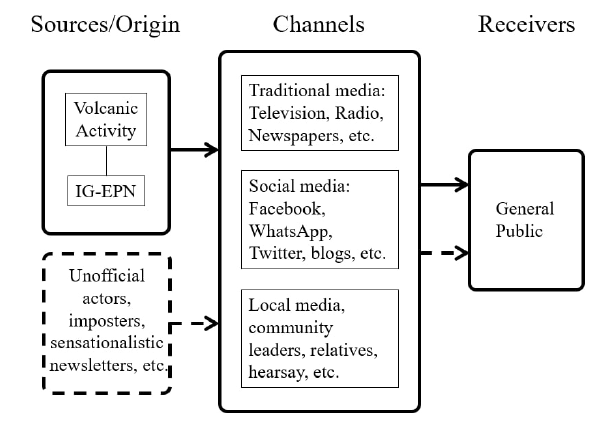
Figure 1: Simplified summary of the communication process during a volcanic hazard in Ecuador. The dashed lines indicate the potential for inaccurate infor- mation